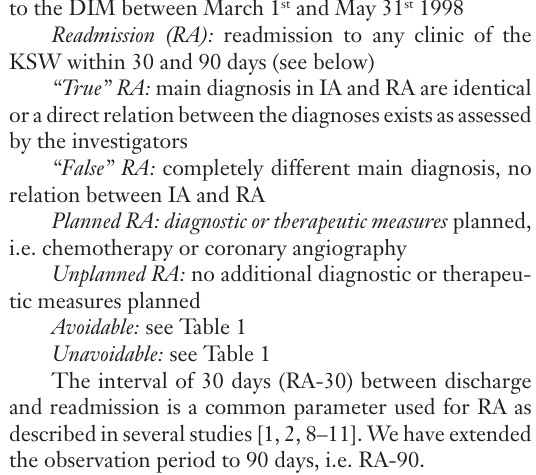
Classification of hospital readmis- sions